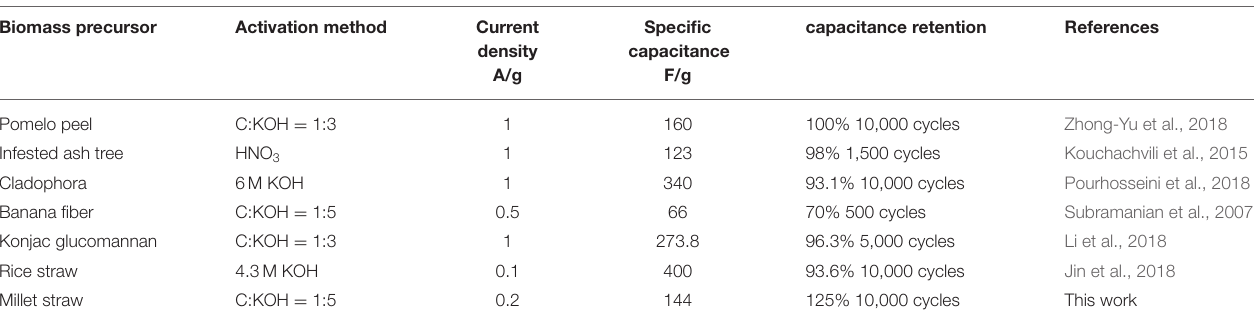
TABLE 2 | Summary of electrochemical performances of biomass activated carbon. Biomass